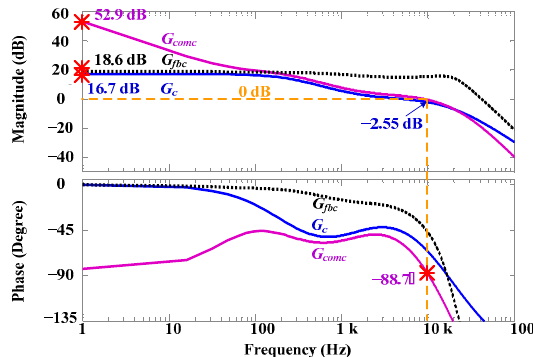
Figure 16. Bode plot simulations: G c ( s ), G comc ( s ), and G fbc ( s ).